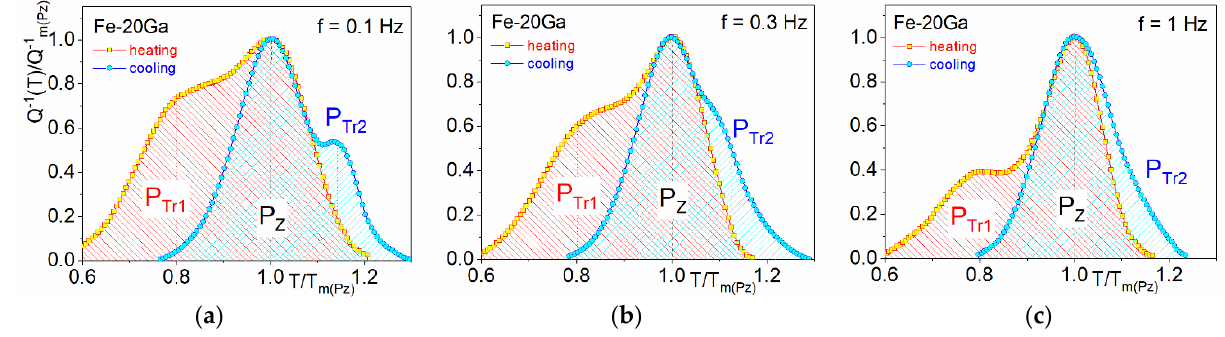
Figure 11. Scheme of the P Tr1 , P Z (or P2) Zener, and P Tr2 peaks combination measured at 0.1 ( a ), 0.3 ( b ), and 1 ( c ) Hz. Peak height and temperature of Zener peak are normalized to 1 on both axes.